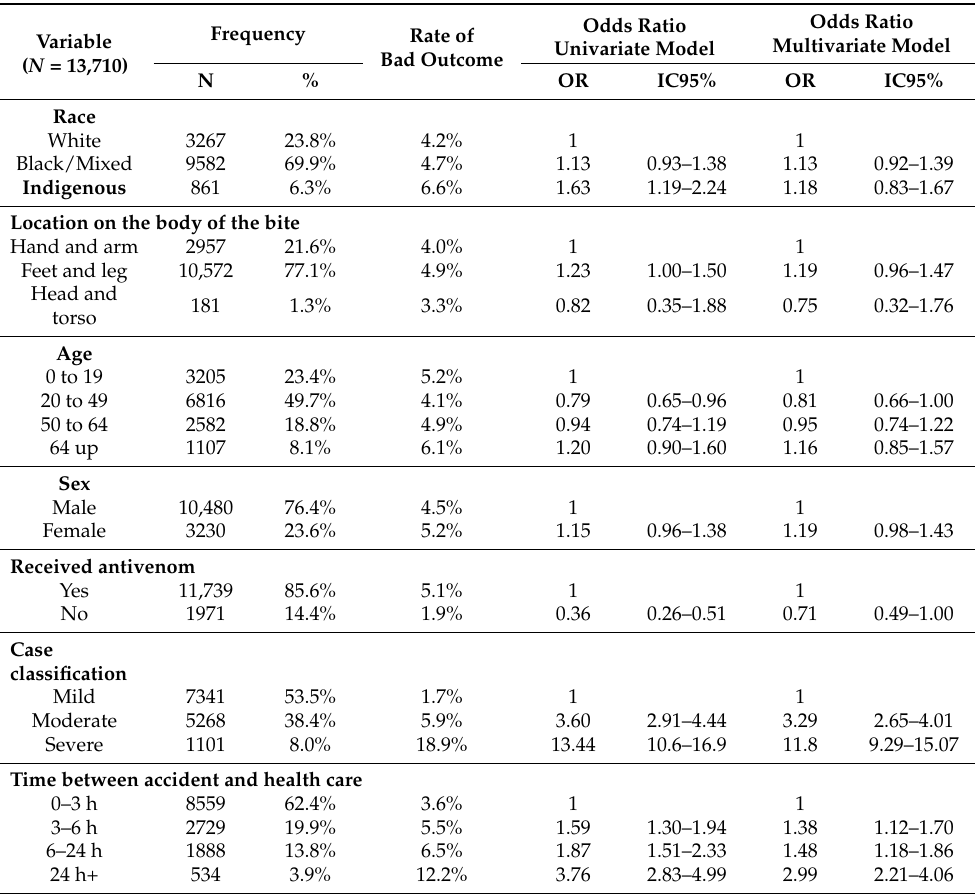
Table 5. Number of bad outcomes by snakebites (death by snakebite and/or local complication and/or systemic complication) and covariables, and results of univariate and multivariate analysis, rural population, Brazil, 2017.